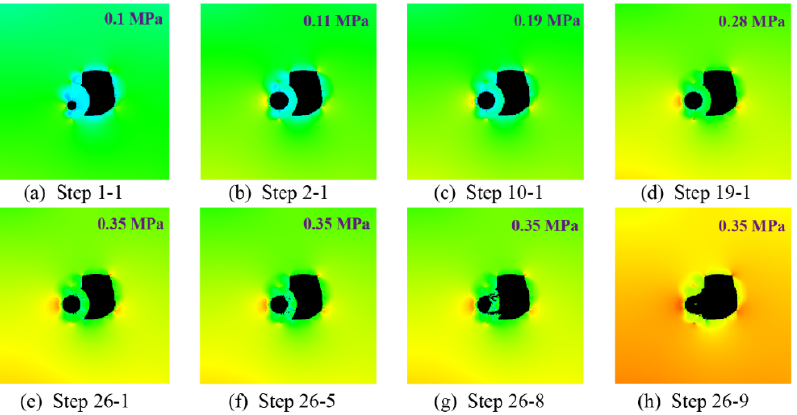
Figure 2. Numerical calculation results of the damage model of the grouted body under the influence of a water-rich cave: ( a – h ).